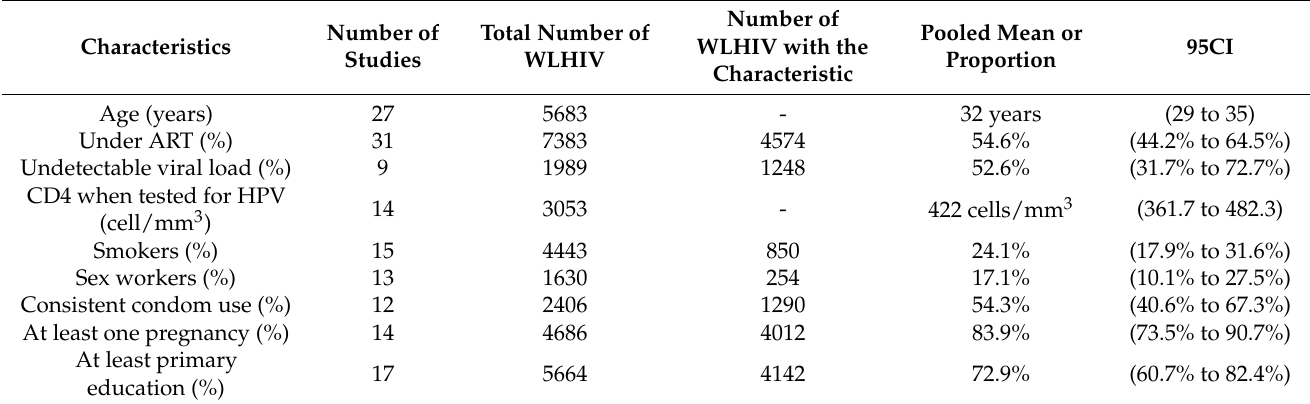
Table 1. Pooled characteristics of the overall